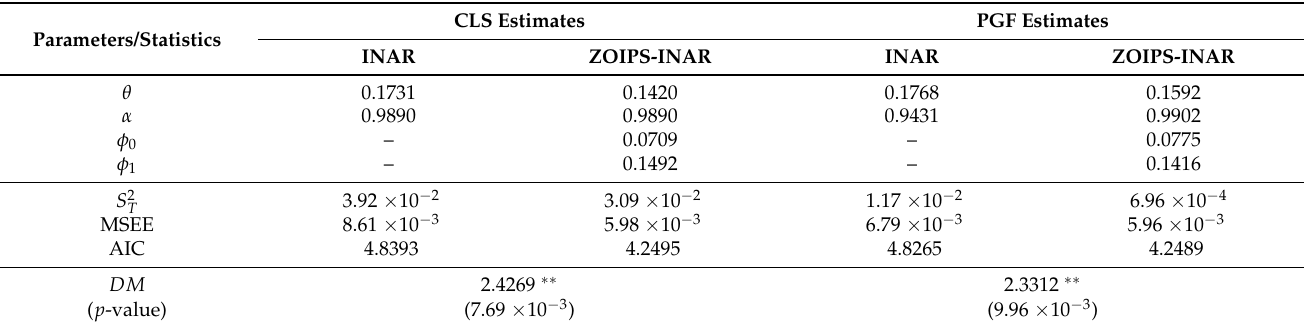
Table 4. Estimated fitting parameters of the considered data with the INAR(1) and ZOIPS-INAR(1) models, along with their goodness-of-fit and predictive statistics. (Poisson distribution is assumed for PS-distributed innovations).